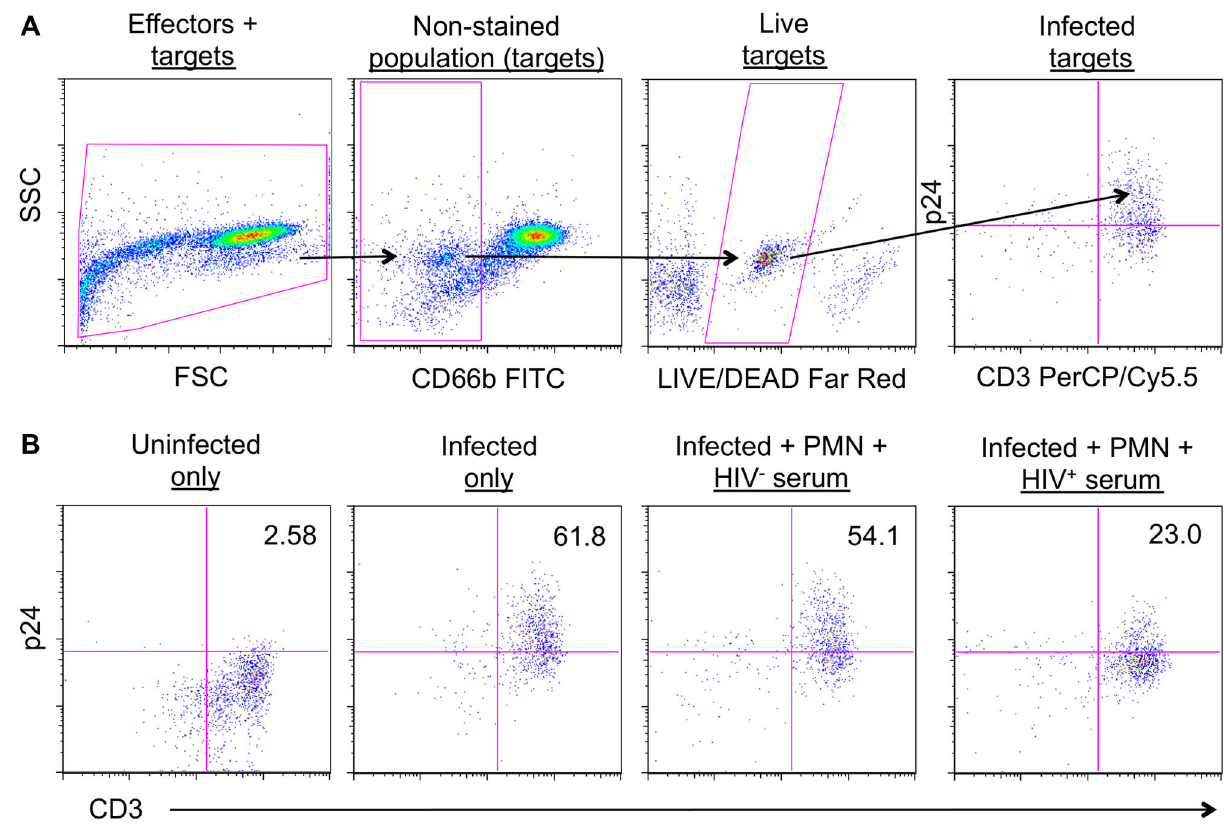
Figure 2. Gating strategy for ICE, Assay. (A) Effector cells were labeled with the phenotypic marker mAbs shown and targets labeled with LIVE/DEAD ® stain and mixed. Live CD4 + T cells (targets) were identified by gating on live cells negative for the effector label (NK, MC, or PMN-FITC). Cells were fixed and stained for p24 to determine the frequency of infected targets. (B) Elimination of HIV-1-infected cells. Representative data show % p24 positive cells for uninfected CD4 + T cells, infected CD4 + T cells, infected CD4 + T cells + PMN + HIV - (control) serum, and infected CD4 + T cells + PMN + HIV + (Bpool) serum. A reduction in the number of p24-stained cells is represented as % ICE and indicates cell death. In the example described above, % ICE [(61.8-23.0)/61.8] × 100 = 62.8%.